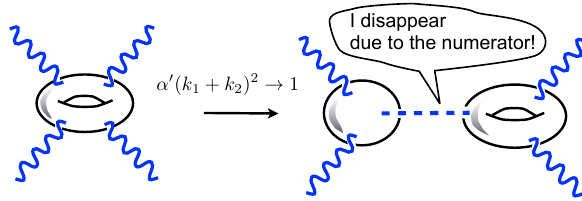
Figure 5 . The double-pole residue ensures that tachyons do not propagate. This statement holds universally for both the present open-string calculation and its closed-string counterpart in section 6, and we are drawing its representative for a torus